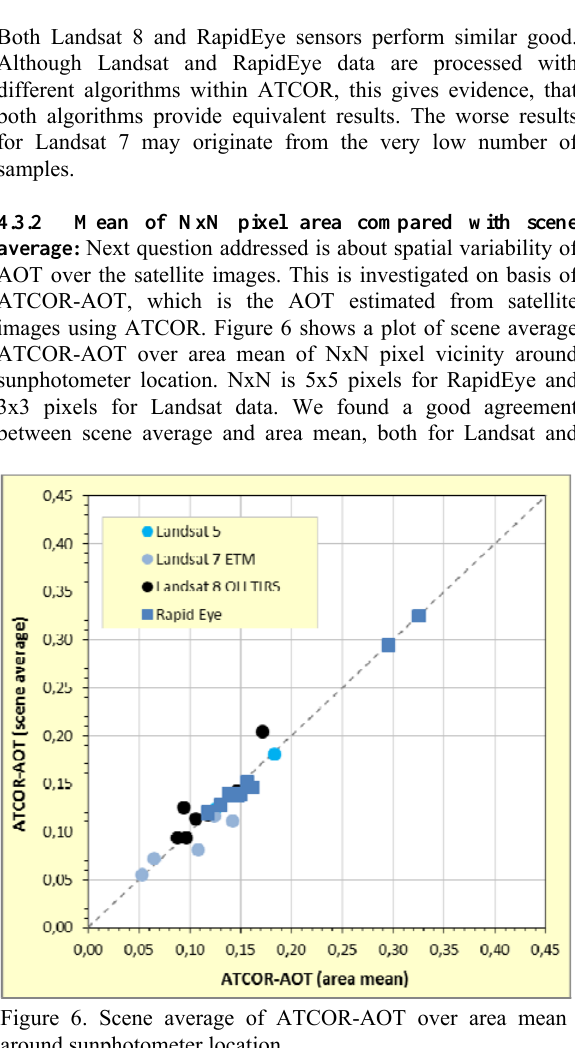
Figure 5. AOT estimated from satellite data using ATCOR compared with in situ-AOT for the regional data set. The grey, long-dashed line is the linear trend through the data points.